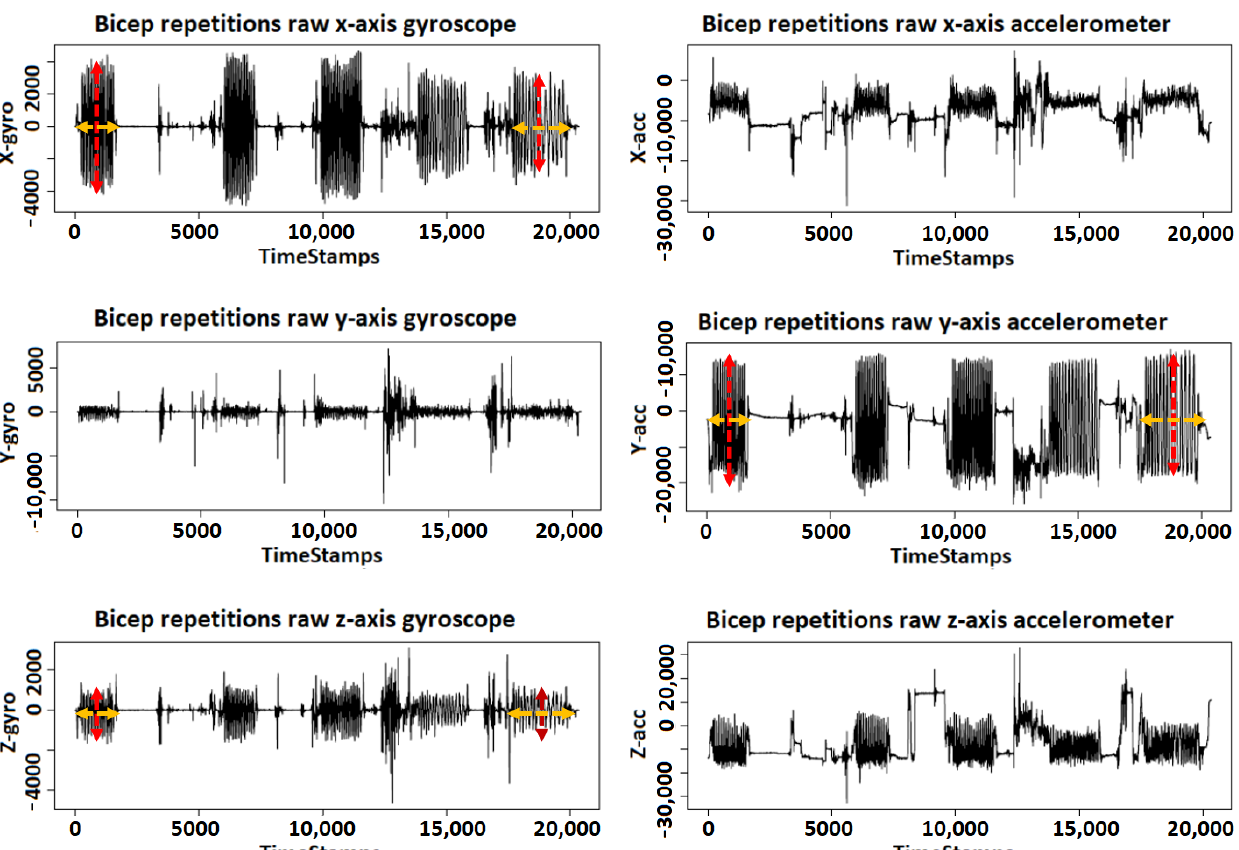
Figure 6. A visualization of the impact of fatigue on collected data.